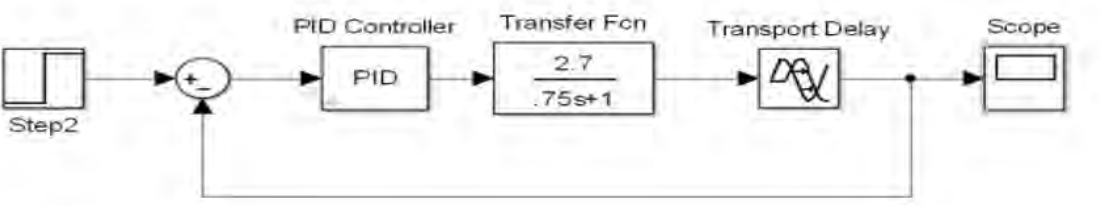
Figure 6. PID simulink of council